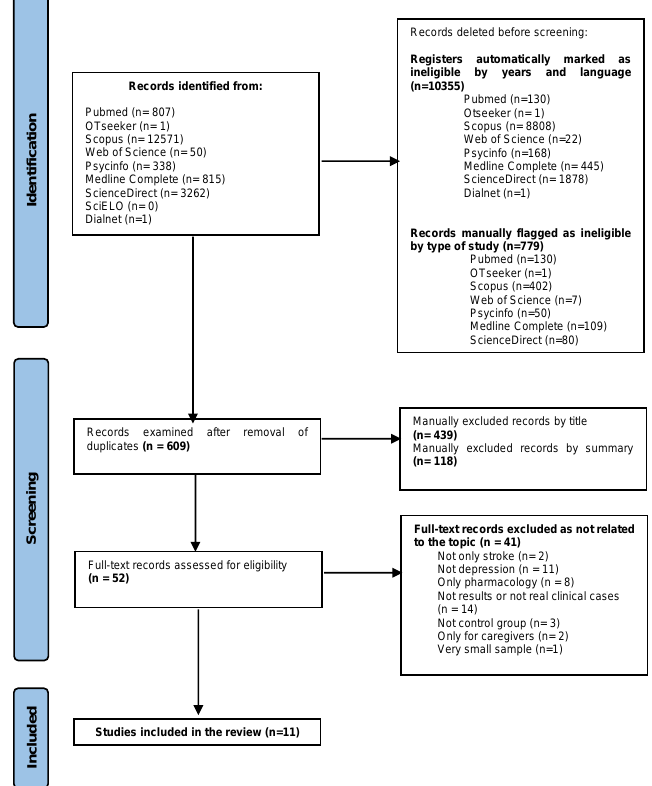
Figure 1. PRISMA Flowchart of search. Figure 1. Flowchart of search